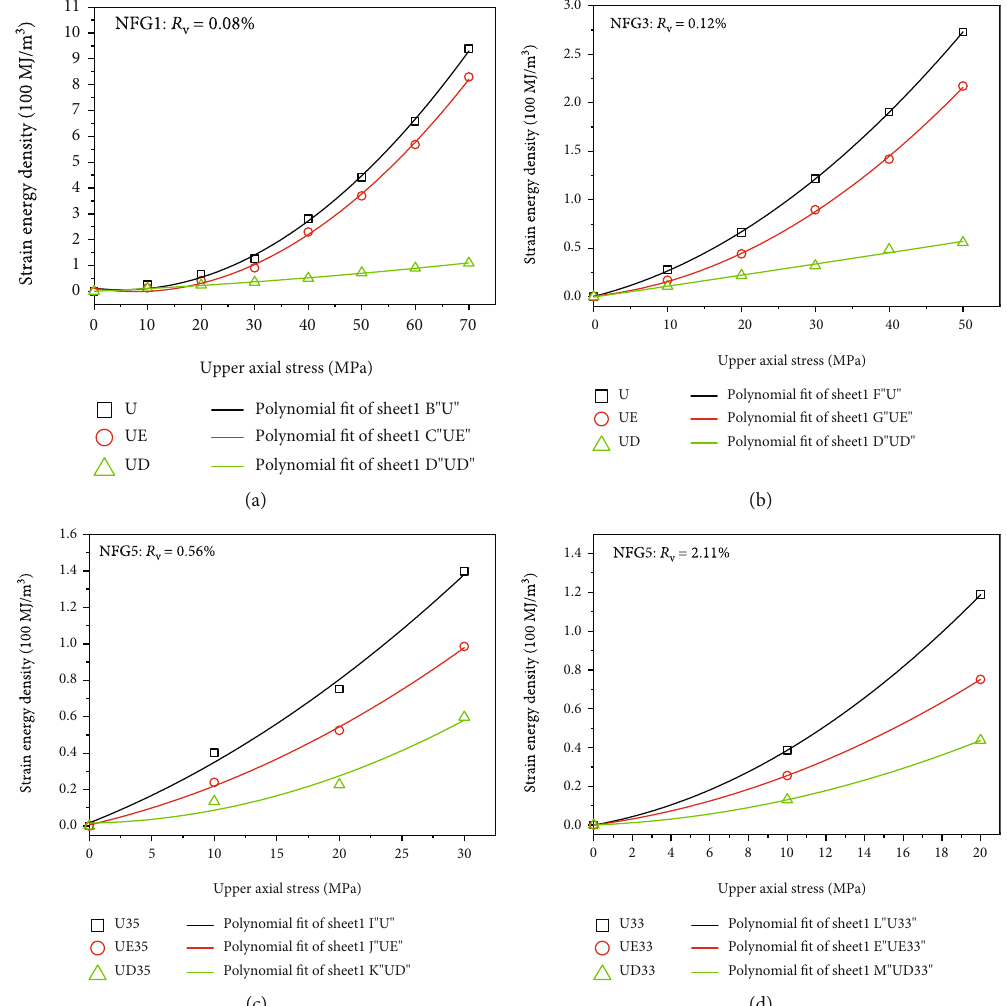
Figure 9: Evolution of the total strain energy, elastic energy, and dissipated energy with the upper axial stress at the last loading cycle of each stage. (a – d) The natural fracture volume is 0.08%, 0.12%, 0.56%, and 2.11%,